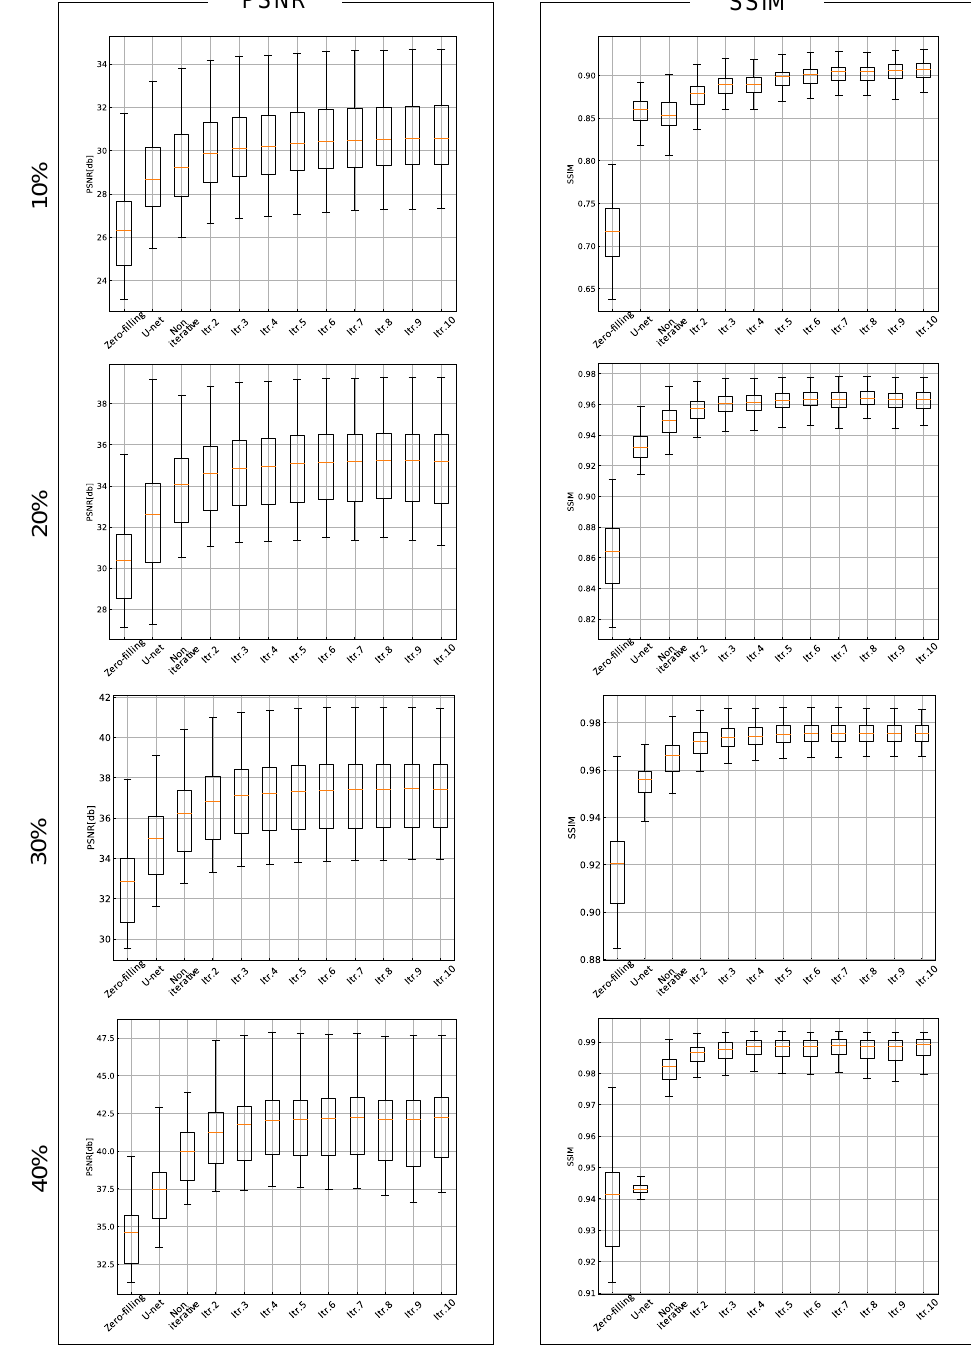
Figure 5. Quantitative results in terms of PSNR and SSIM obtained by different methods for all Cartesian sampling masks. In each plot, the yellow line within the box represents the median; the lower and upper lines of the box represent the 25th and 75th percentiles, respectively; and the lower and upper adjacent lines (whiskers) represent the minimum and maximum values, respectively.